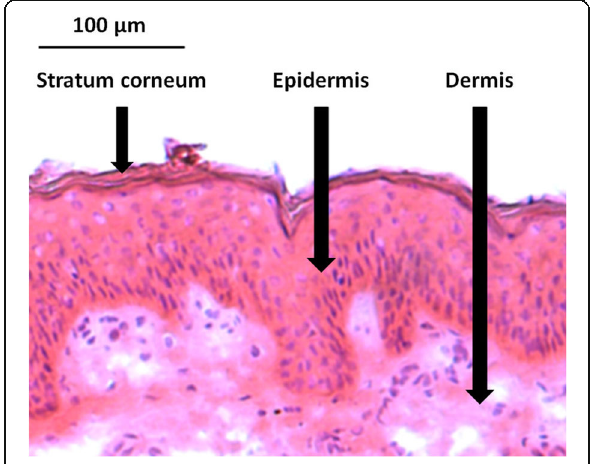
Fig. 1 Hematoxylin and eosin staining of human skin, illustrating the layers of the stratum corneum, epidermis, and dermis. Image provided by author